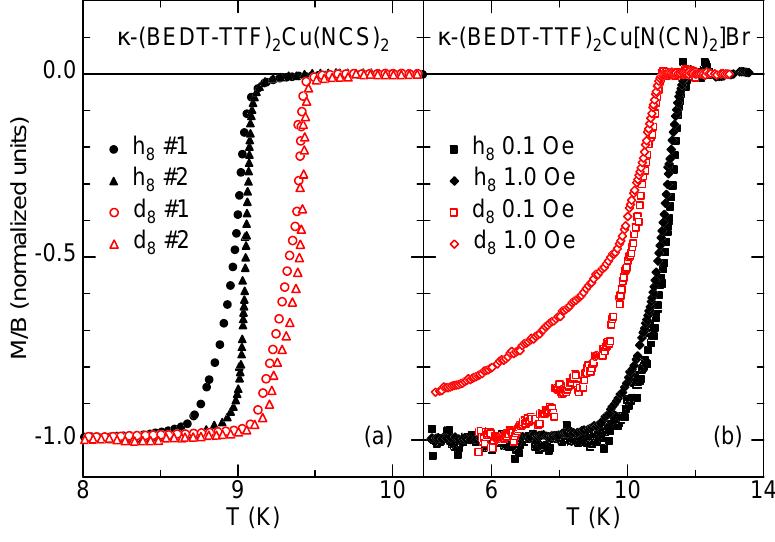
Figure 7. Magnetization curves for ( a ) two protonated (h (cid:20) -(BEDT-TTF) Cu(NCS) samples and for ( b ) a protonated and deuterated (cid:20) 2 2